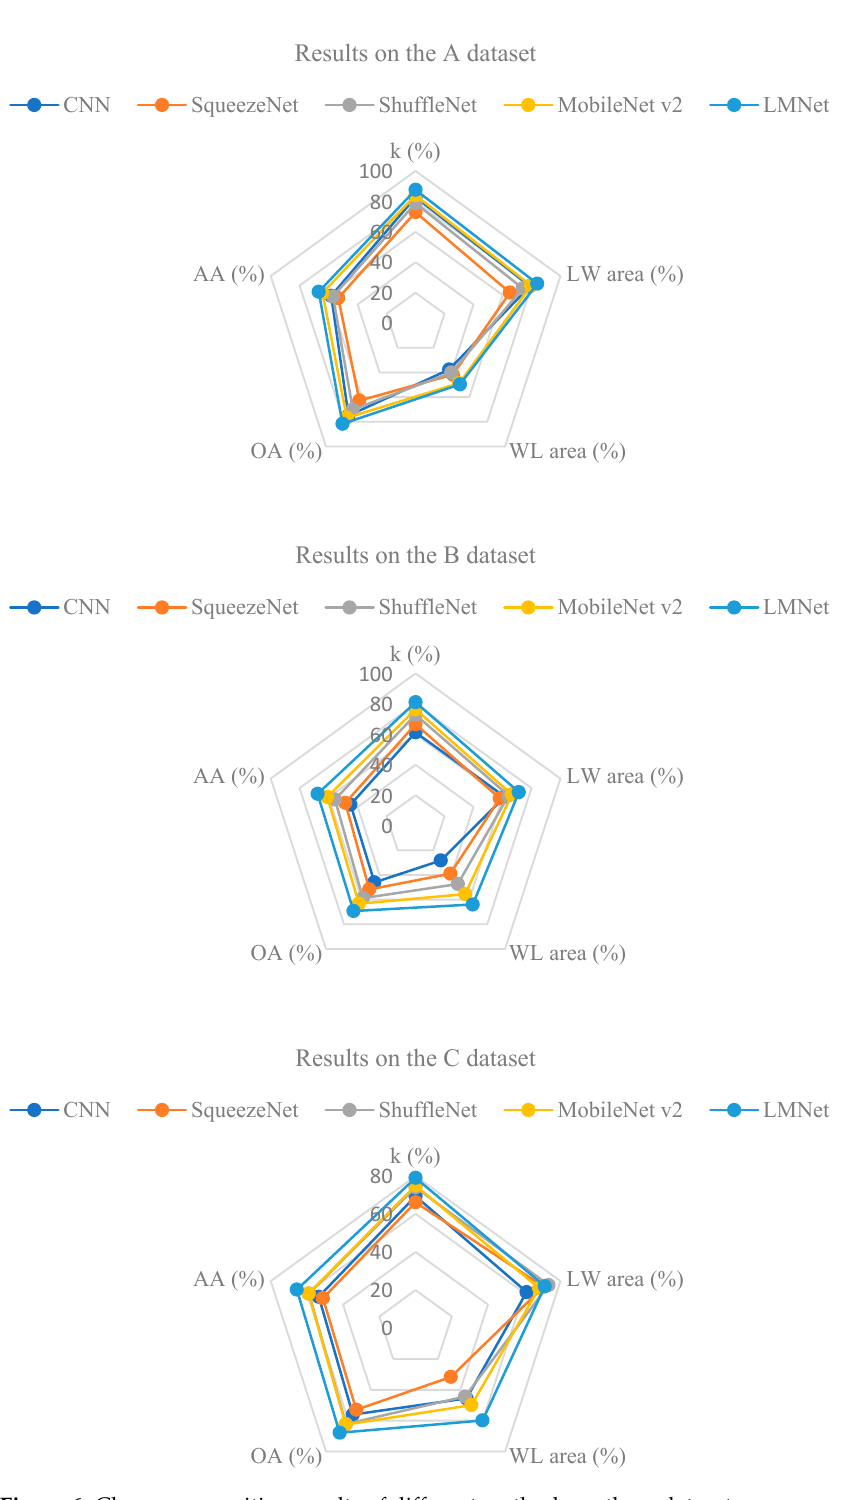
Figure 6. Change recognition results of different methods on three